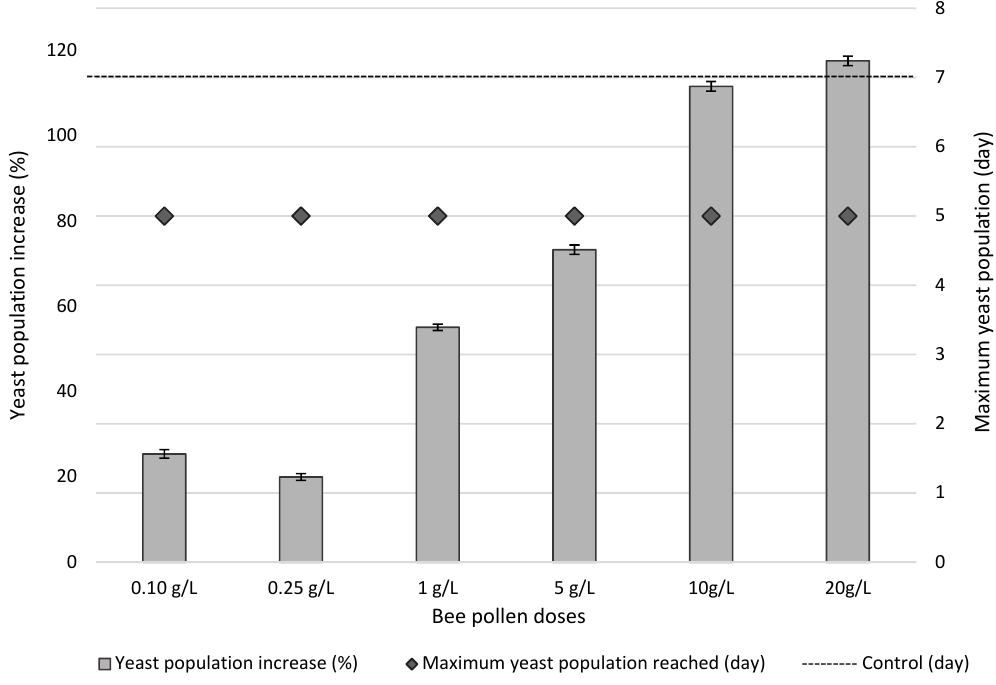
Figure 4. Increase in yeast populations during alcoholic fermentation of Tintilla de Rota grape-must with different bee pollen doses. Different letters mean significant differences between samples (ANOVA, p < 0.05).